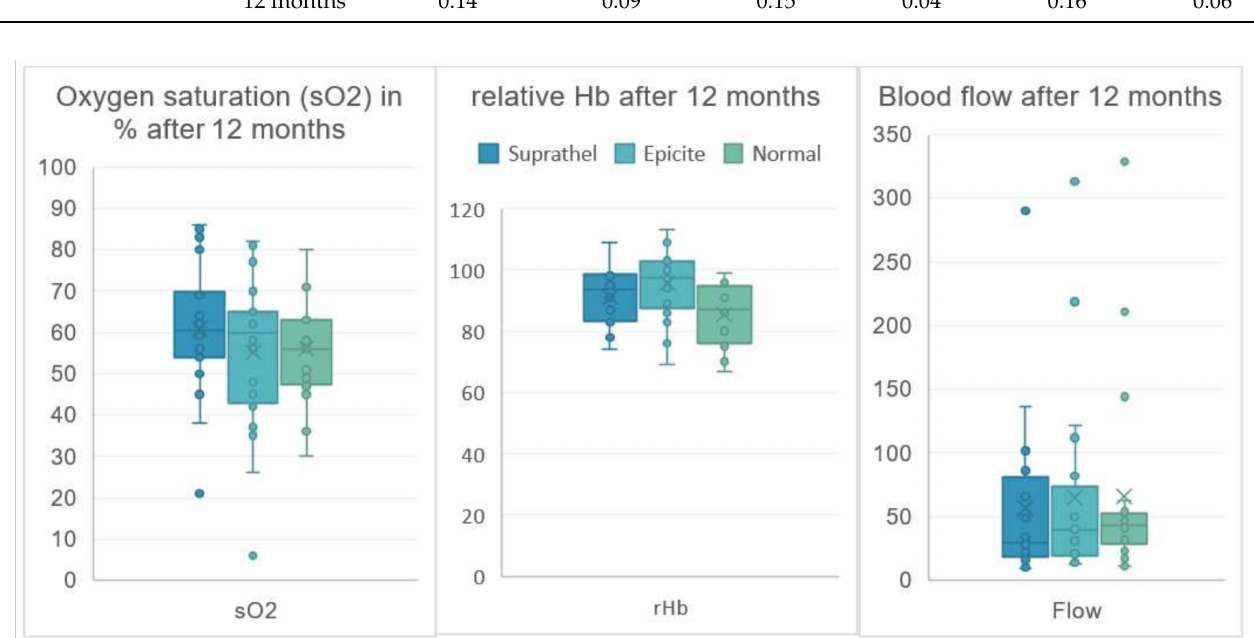
Figure 3. Oxygen Saturation in %, relative Hb and blood flow in Arbitrary Units of treated and untreated areas after 12